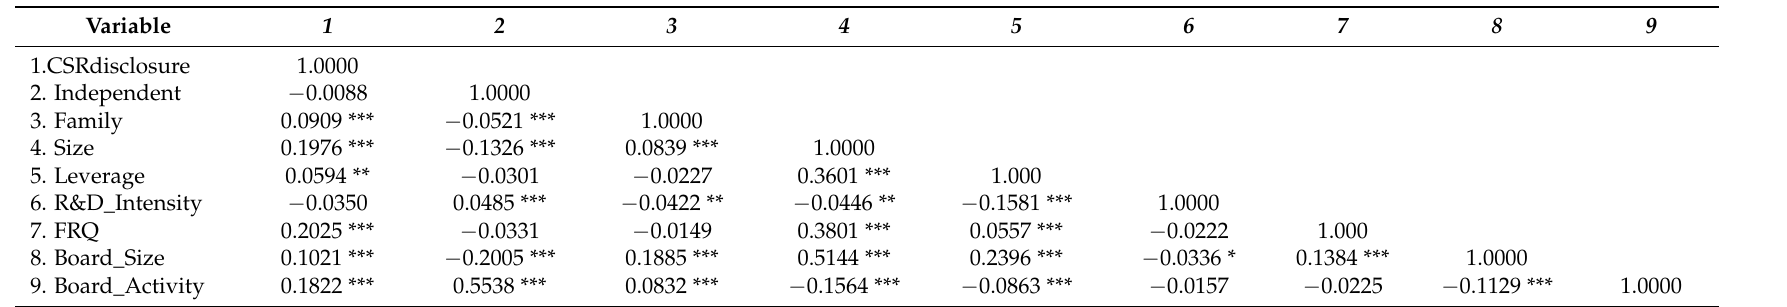
Table 3. Pearson